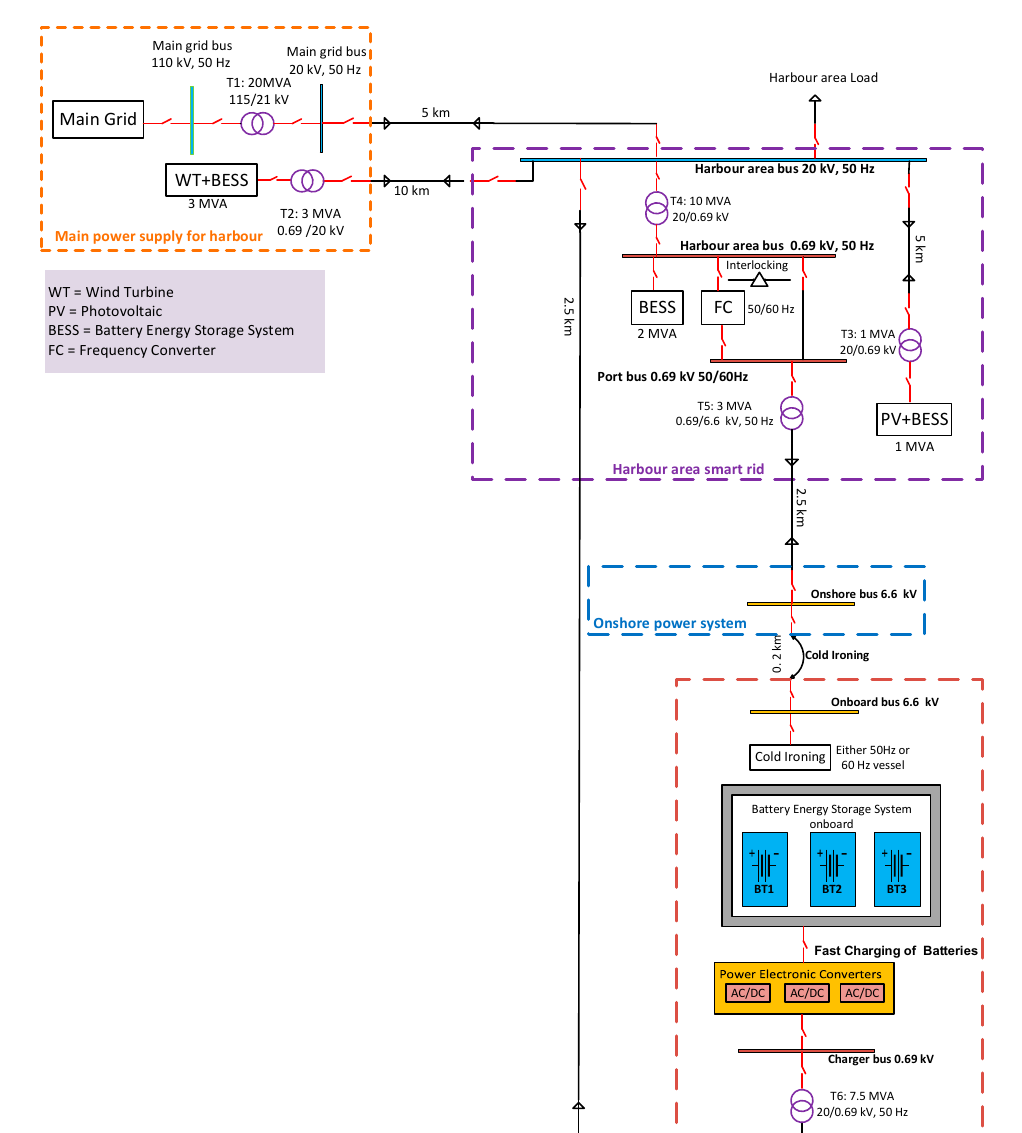
Figure 4. Configuration C: Fast charging of onboard batteries with an AC power supply from shoreside and onshore power is with a separate connection.